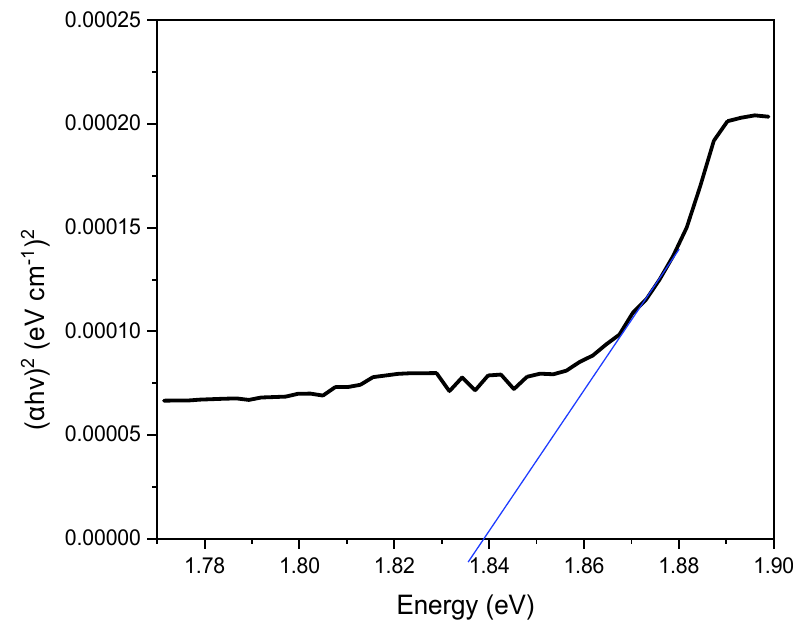
Figure 4. Calculation of band gap using Tauc plot.